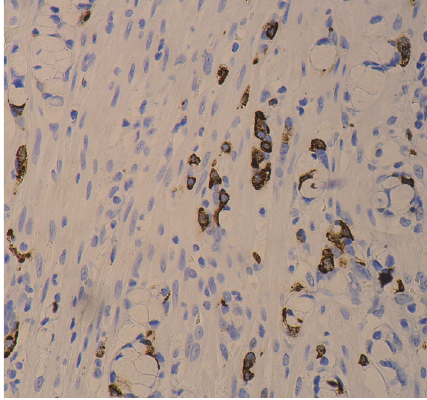
treatment for hypertension and was not submitted, previ- ously, to any kind of operation.